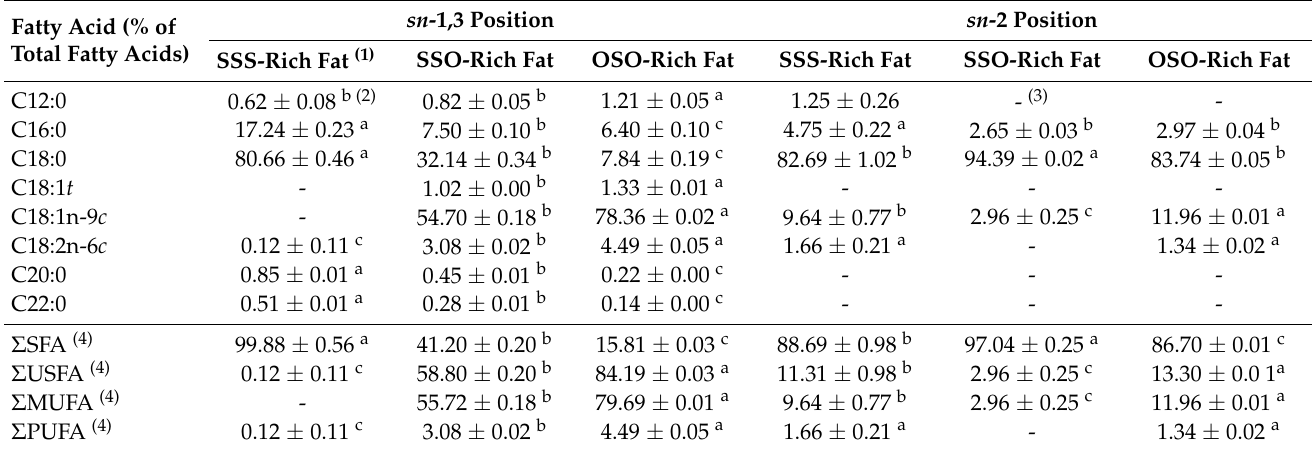
(1) SSS-rich fat: Fully hydrogenated soybean oil; (2) Mean ± SD ( n = 2). a–c Means in the same row with different letters are significantly different by Duncan’s multiple range test at p < 0.05; (3) Not Detected; (4) SFA: Saturated fatty acid, USFA: Unsaturated fatty acid, MUFA: Monounsaturated fatty acid, PUFA: Polyunsaturated fatty acid. 2.2. Acylglycerol and TAG Composition The acylglycerols of SSS-rich fat consisted mainly of TAGs (98.31 mmol%), and small amounts of diacylglycerol (DAG) (1.38 mmol%) containing more 1,3-DAG than 1,2-DAG and monoacylglycerol (MAG) (0.31 mmol%) containing more 1-MAG than 2-MAG (Table 3). The acylglycerols of SSO- and OSO-rich fats consisted of mostly TAG (94.68–98.58 mmol%), and a small amount of DAG (0.97–4.78 mmol%) that contained more 1,3-DAG (0.55–3.65 mmol%) than 1,2-DAG (0.42–1.13 mmol%), and MAG (0.45–0.53 mmol%), which contained more